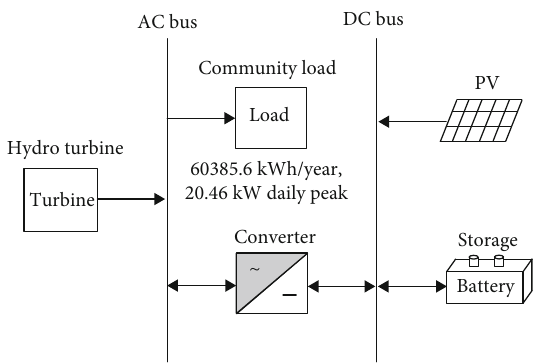
Figure 17: Schematic diagram for the o ff -grid hybrid PV and hydro minigrid system with